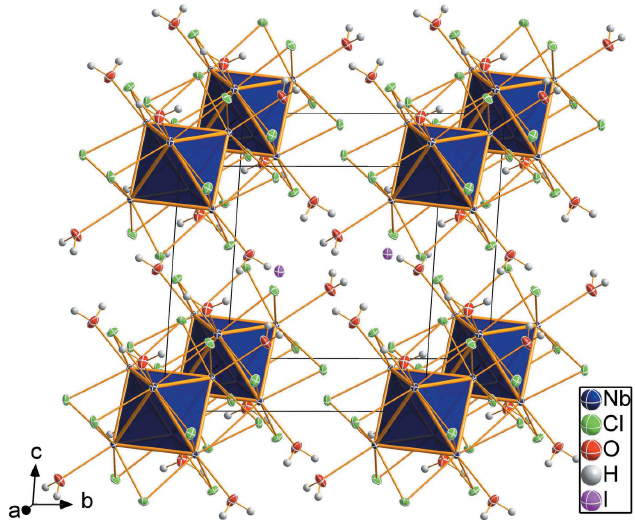
Figure 2 Packing of the cluster cations and iodide anions in the crystal of the title compound.